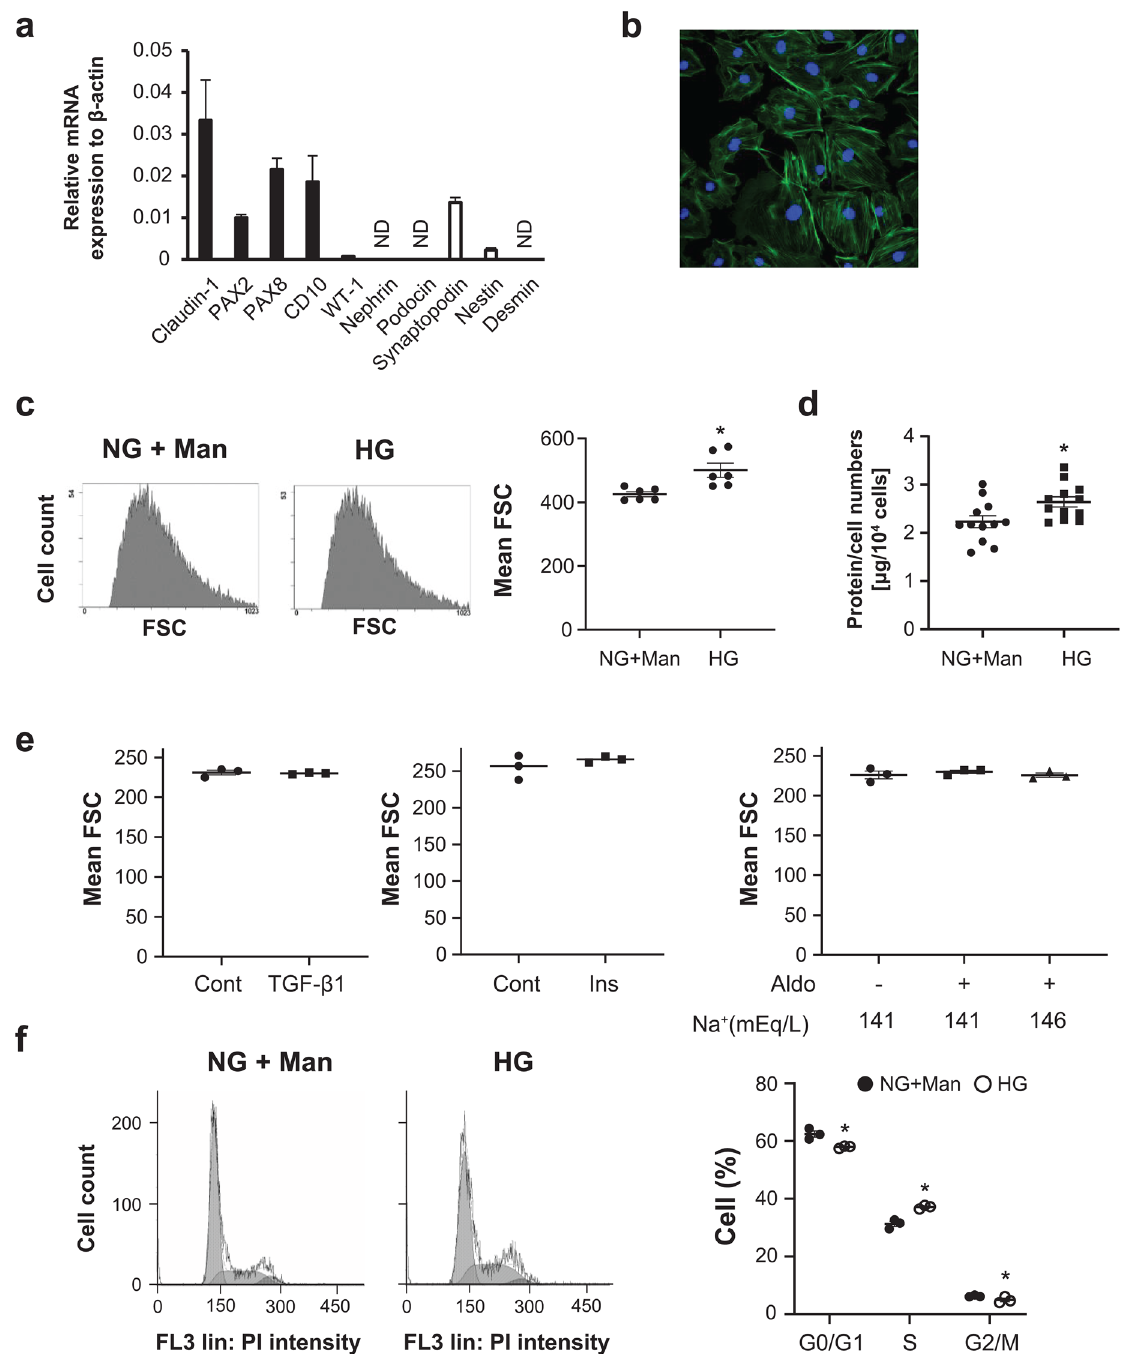
Figure 2. The mechanisms for PEC hypertrophy. (a) The relative mRNA expressions of PEC-specific (black bars) and podocyte-specific (white bars) transcripts in mouse PECs. Quantitative PCR analysis was performed in three independent experiments per each molecule. Values were normalized to the mRNA expression of β-actin as the housekeeping gene and were expressed as mean ± SE (n = 3). (b) A representative photograph of F-actin staining of mouse PECs. (c) Representative flow cytometry images of cultured PECs exposed to RPMI medium containing 5 mM of glucose (normal glucose, NG) with 25 mM of mannitol (Man) or 30 mM of glucose (high glucose, HG) for 24 h. The dot plot graph on the right shows the mean FSC (forward scatter) values. *P < 0.05 vs. NG + Man group (n = 6). (d) The value of the protein/cell number of PECs exposed to NG + Man or HG. *P < 0.05 vs. NG + Man group (n = 12). (e) Cultured PECs were exposed to RPMI medium with or without TGF-β1 (10 ng/mL), insulin (Ins, 300 nM) or aldosterone (Aldo, 10 −7 M), in the presence of 141 or 146 mEq/L of sodium ion (n = 3). (f) The effects of glucose on the cell cycle in PECs. PECs were exposed to HG (30 mM) or normal glucose (5 mM) with mannitol (25 mM) culture for 24 h. The percentages of the cells in the G 0 /G 1 , S and G 2 /M phases were determined by computer analysis. *P < 0.05 vs. NG + Man group (n =